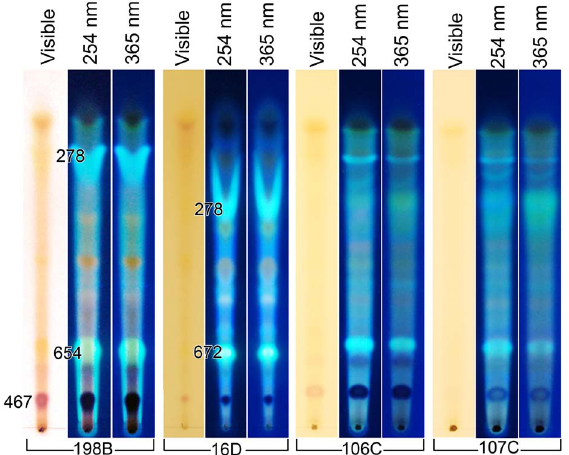
Figure 6. Extracted pigments and fluorescent compounds of Cryptococcus using small volumes of methanol. The methanol extracted pigments and fluorescent compounds of C. gattii , serotype B, (198B), C. neoformans var. neoformans (16D), and C. gattii, serotype C (106 and 107). The cells were extracted once with a small quantity of methanol. This type of extraction greatly favored obtaining the fluorescent compounds and minimized the extraction of the brown pigments. The figure also suggests that metabolic differences between the C. gattii strains exist. The solvent system was 75% methanol, pH 7. The molecular mass for several compounds was determined.